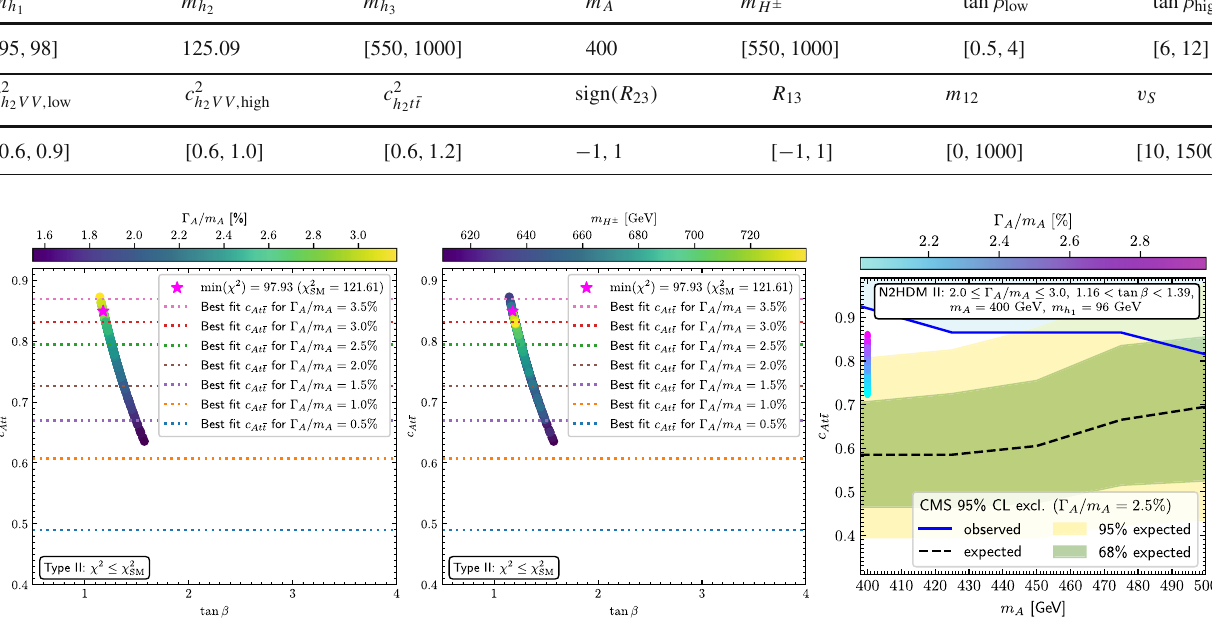
in comparison to the observed (blue) and expected (black dashed) upper limits at the 95% CL as well as the corresponding 1 σ (green) and 2 σ (yellow) regions around the expected limit assuming (cid:8) A / m A = 2 . 5%, as published in Ref.